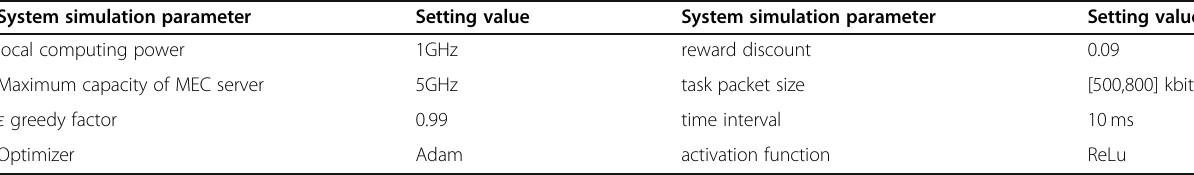
Table 1 Simulation